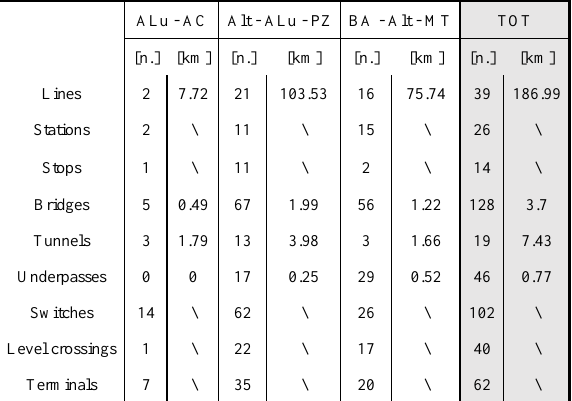
Table 3. FAL railway elements classification.